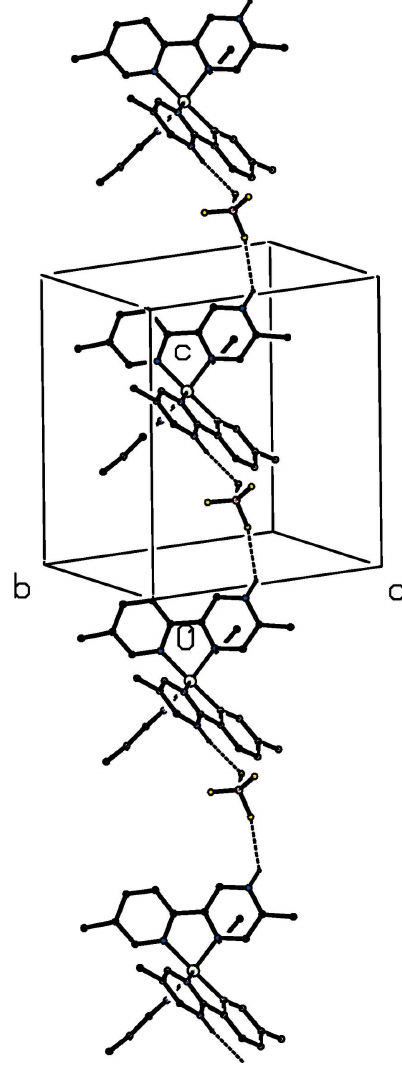
Figure 12 Part of the crystal structure of compound (VI) showing the formation of a hydrogen-bonded C 2 (12) chain running parallel to the [001] direction. 2 For the sake of clarity, the tcnopr anion and the H atoms not involved in the motif shown have been